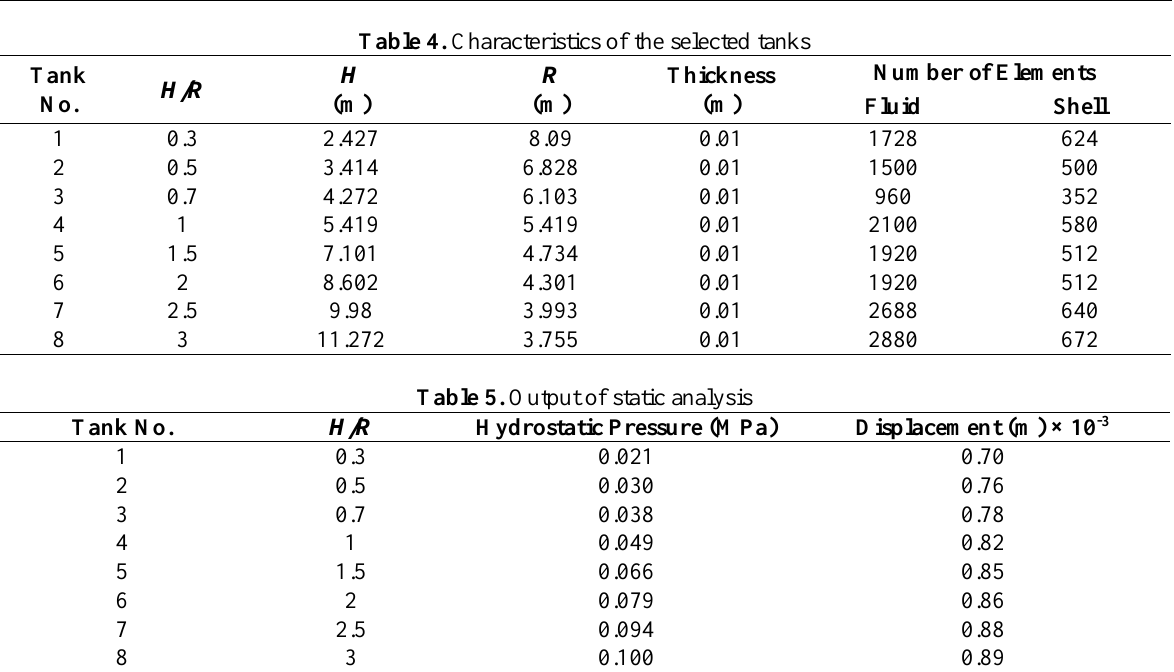
Table 6. Comparison of impulsive and convective parameters